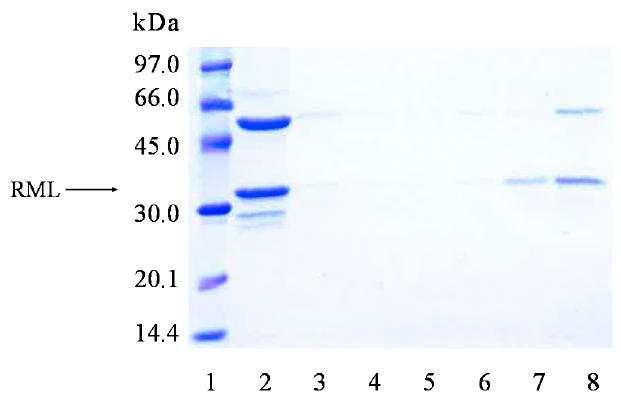
Figure 7. SDS-PAGE analysis of octyl-VS-CALA-PEI-RML after incubation and washing with solutions having different concentrations of ammonium sulfate (AS). Lane 1: Low weight molecular markers; Lane 2: initial preparation; Lane 3: after incubation in 0.1 M AS; Lane 4: after incubation in 0.25 M AS; Lane 5: after incubation in 0.5 M AS; Lane 6: after incubation in 1.0 M AS; Lane 7: after incubation in 2.0 M AS and Lane 8: after incubation in 4.0 M AS. Other specifications are described in Methods.